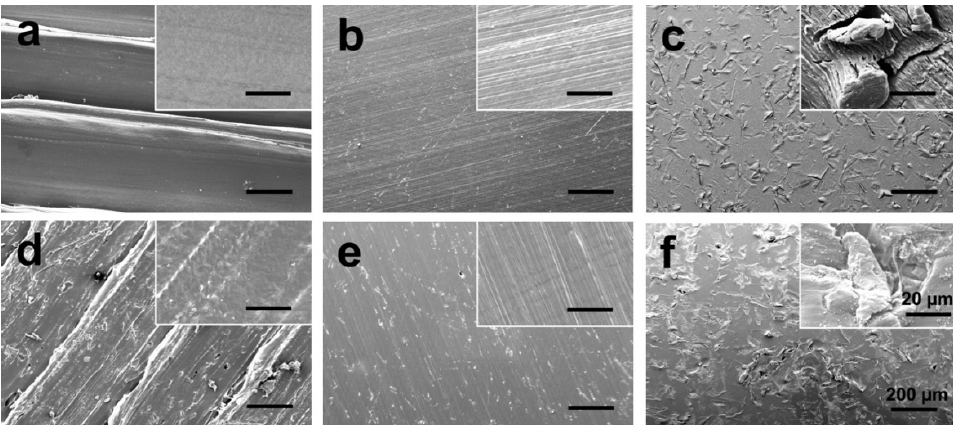
Figure 3. SEM images of PEEK and CFR‐PEEK composite: ( a ) untreated PEEK; ( b ) polished PEEK; ( c ) sandblasted PEEK; ( d ) untreated CFR‐PEEK; ( e ) polished CFR‐PEEK; ( f ) sandblasted CFR‐PEEK. Bars represent 200 μm and 20 μm (inserts), respectively.